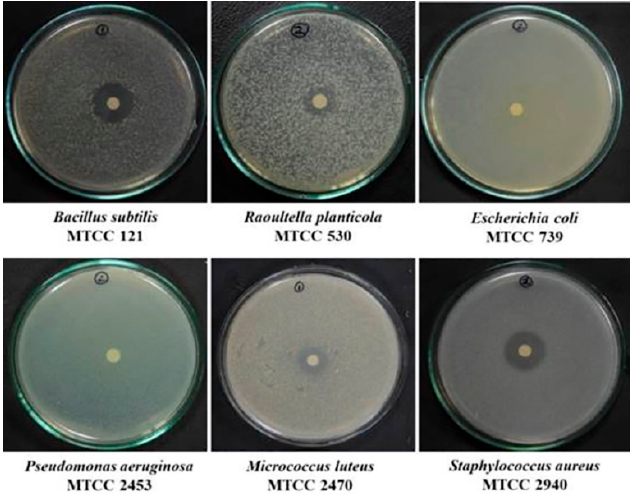
Figure 10. Antimicrobial activity of hexane extract of G. triuniae NFCCI 4873 against different test bacteria.